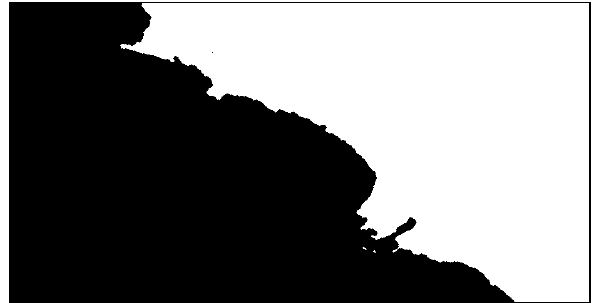
Figure 9. The result of Fit-Coast algorithm application Sobel operator was applied on the binary image generated by fit-coast algorithm and then image was converted to vector data (Figure